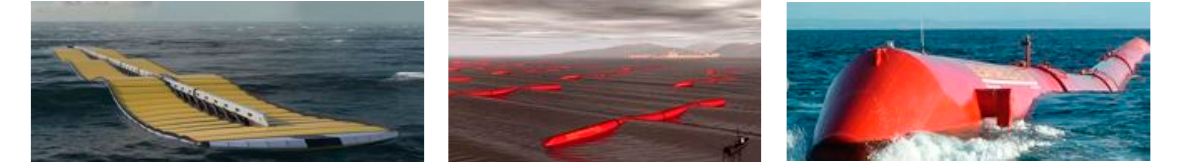
Figure 30. Three Gorges Dam in China [67].